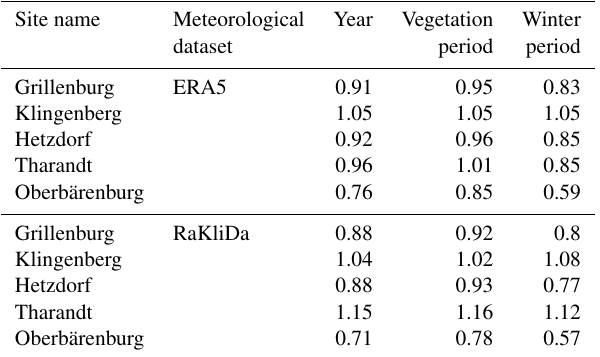
Table 3. Precipitation bias (to in situ